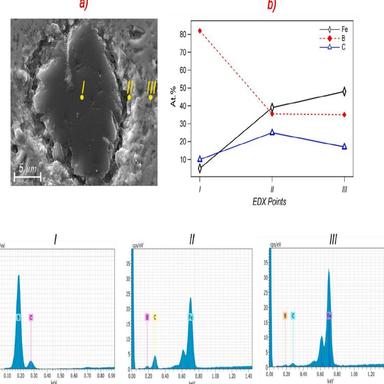
a) EDX analysis of the I-residual B4C particle, II- particle-diffusion zone interface, III- diffusion zone-matrix interface, b) Elemental distribution of points.